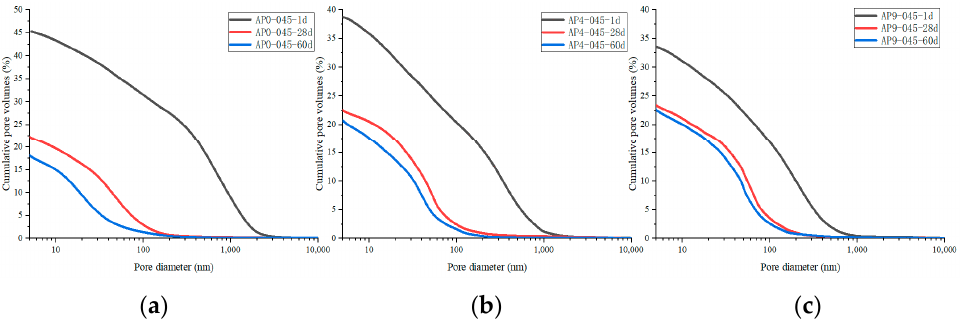
Figure 12. The porosity of hydrated cement pastes with different dosages of the AS accelerator: ( a ) PA0-045; ( b ) PA4-045; ( c ) PA9-045.